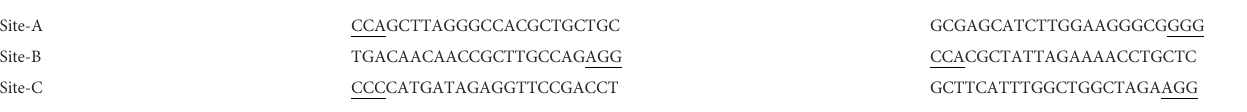
TABLE 1 gRNAs for site-speci fi c integration into three regions with speci fi c histone modi fi cations using Cas9 nickases. Site-A